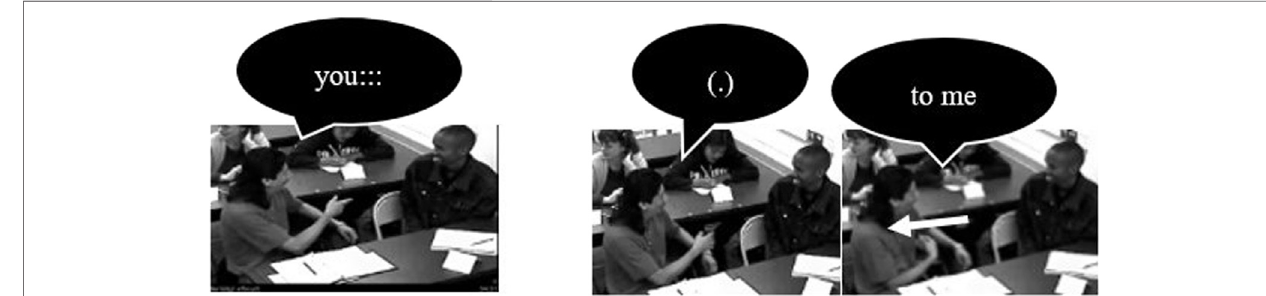
FIGURE 3 | Extract 2. line 1.